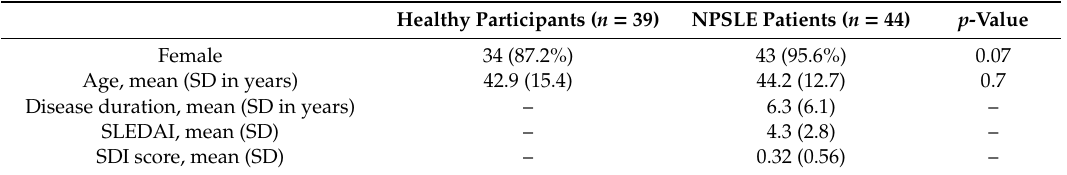
Table 1. Demographic and clinical characteristics of NPSLE patients and